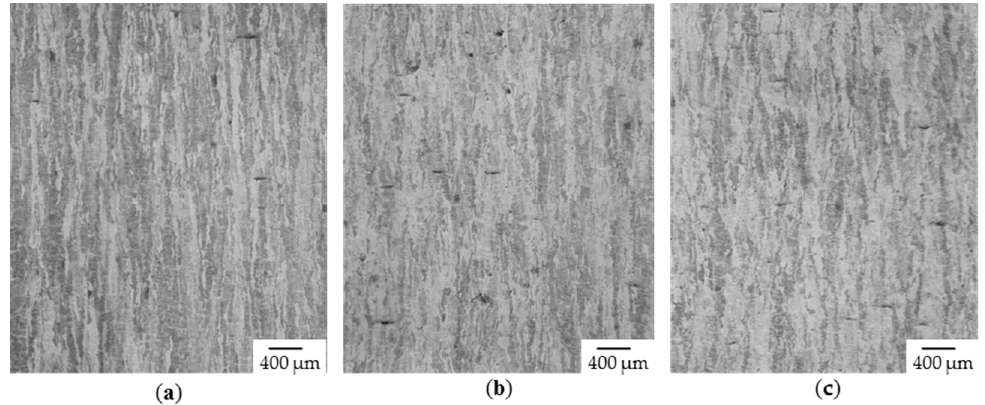
Figure 14. Etched cross-section (optical microcopy) with constant P L = 133 W, vs = 80 mm/s, µm, T pre = 20 °C ( a ) Δ y = 60 µm, w g = 108 µm ( b ) Δ y = 70 µm, w g = 103 µm ( c ) Δ y = 60 µm, w g = 83 µm.